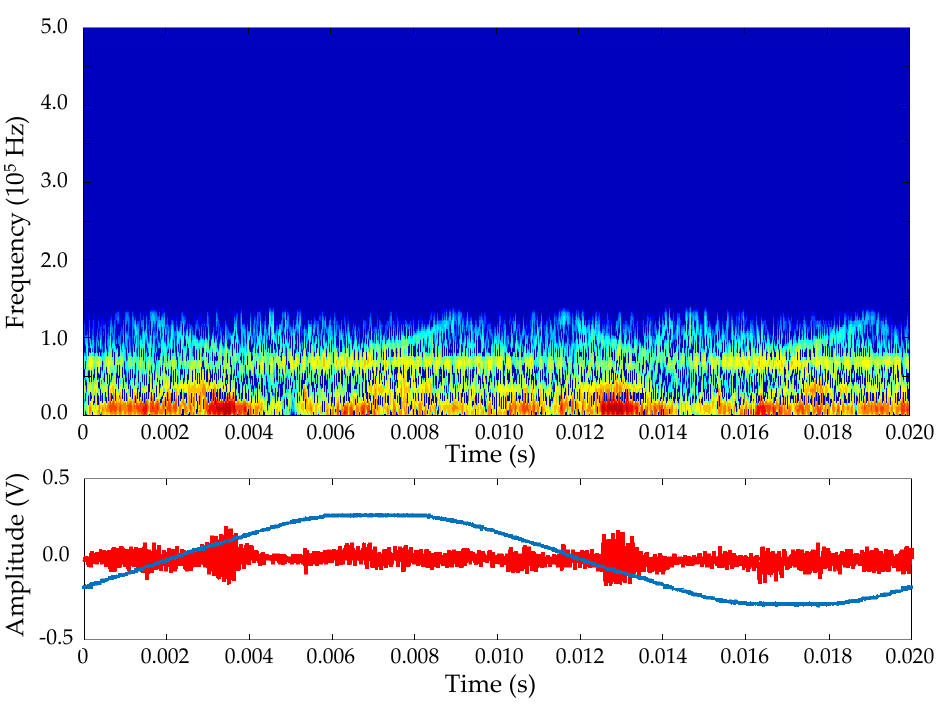
Figure 12. Pseudo Wigner-Ville transform analysis for the sub rural site in the time-frequency domain.